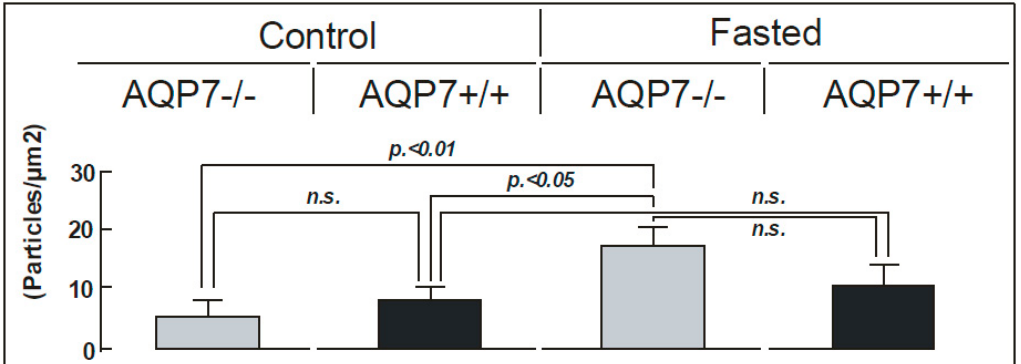
Figure 4. Numbers of gold particles/µm 2 in capillary endothelia of WAT from control and fasted mice (control: AQP7 − / − , AQP7+/+; fasted: AQP7 − / − , AQP7+/+). Quantitation of the electron